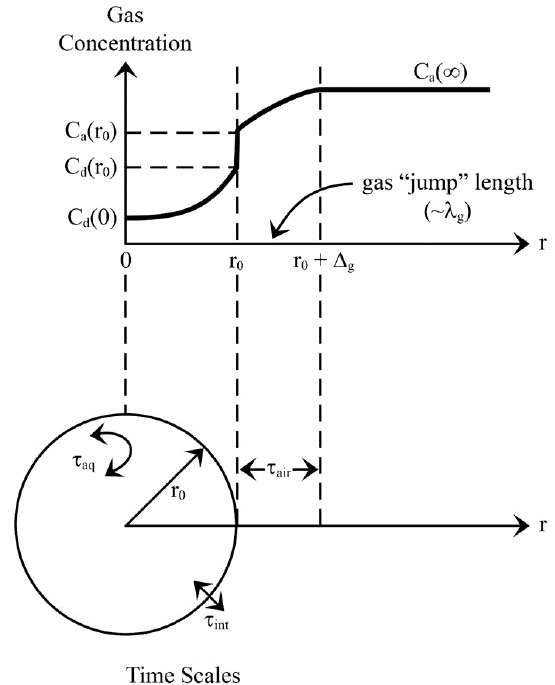
Figure 3. Gas invasion example. The upper part of the figure shows the gas concentration C as a function of radial distance r from the center of a spray droplet. The apparent discontinuity in concentration at r 0 is required by Henry’s law equilibrium. The lower part depicts the three time scales ( τ air , τ int , τ aq ) defined in Section 2.3, relevant to spray-mediated gas exchange. Adapted from Seinfeld and Pandis (2006, p. 550) and Lamb and Verlinde (2011, p. 502).